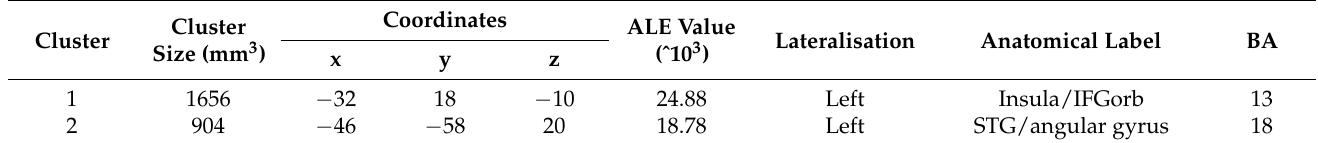
Table 4. Results of the meta-analysis on guilt processing.